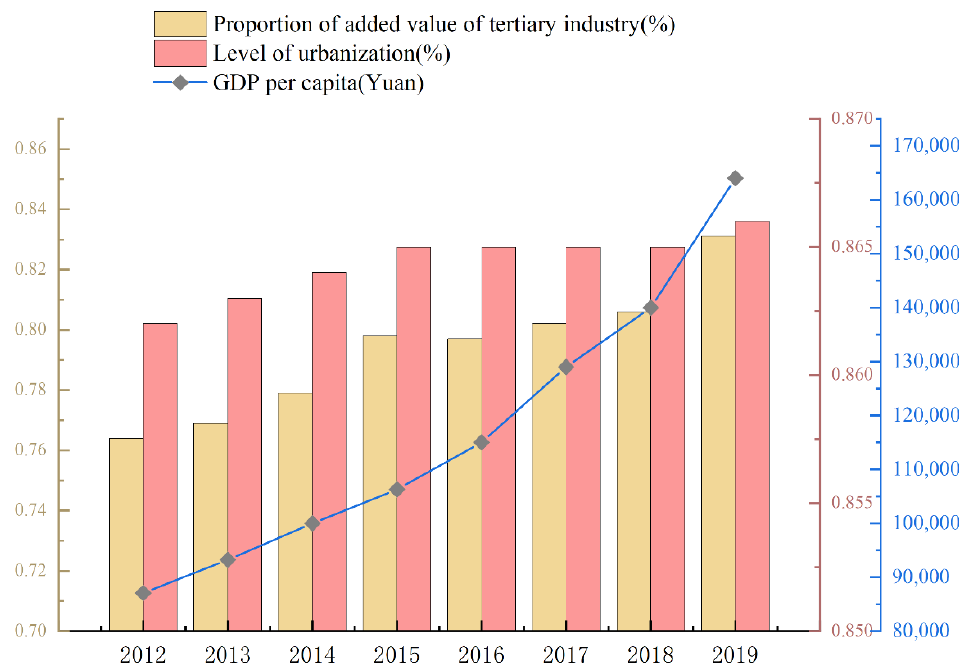
Figure 2. In dex data affecting carbon emission in Beijing. Figure 2. Index data affecting carbon emission in